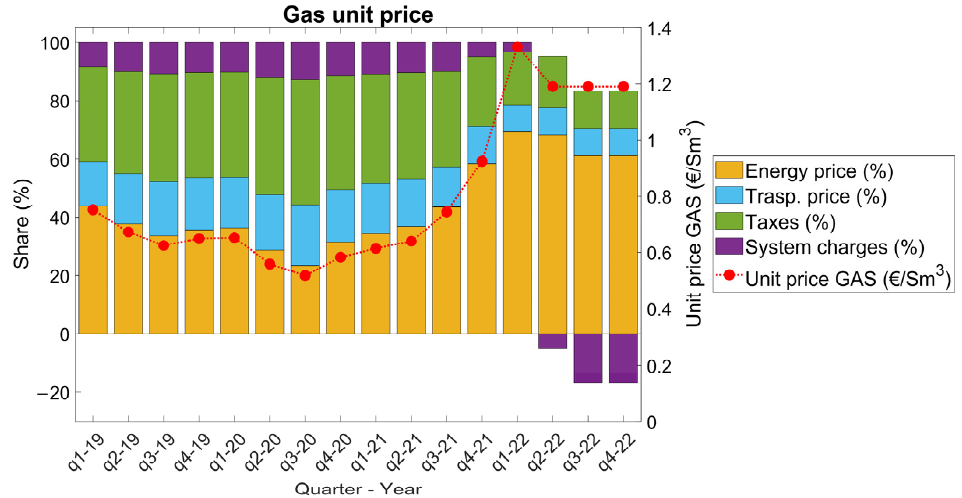
Figure 6. Unit gas prices (EUR/Sm 3 ) and price component shares (%), period of 2019–2022. The figure refers to unit gas prices for Milan.